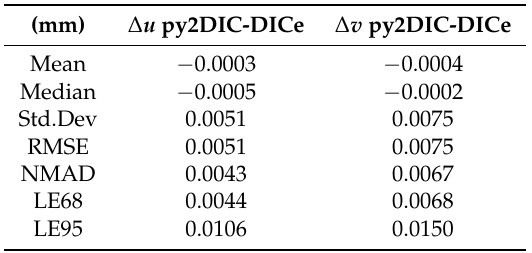
Table 8. Comparison with DICe : statistical parameters of displacement differences.